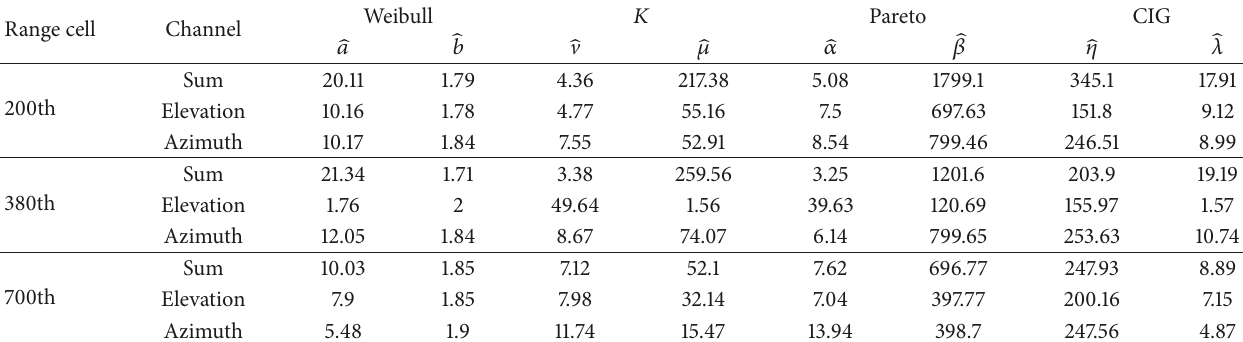
Table 4: Estimated parameters for different theoretical PDFs for